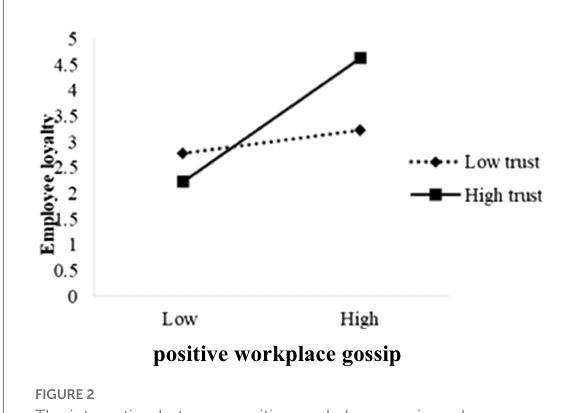
FIGURE 2 The interaction between positive workplace gossip and organizational trust on employee